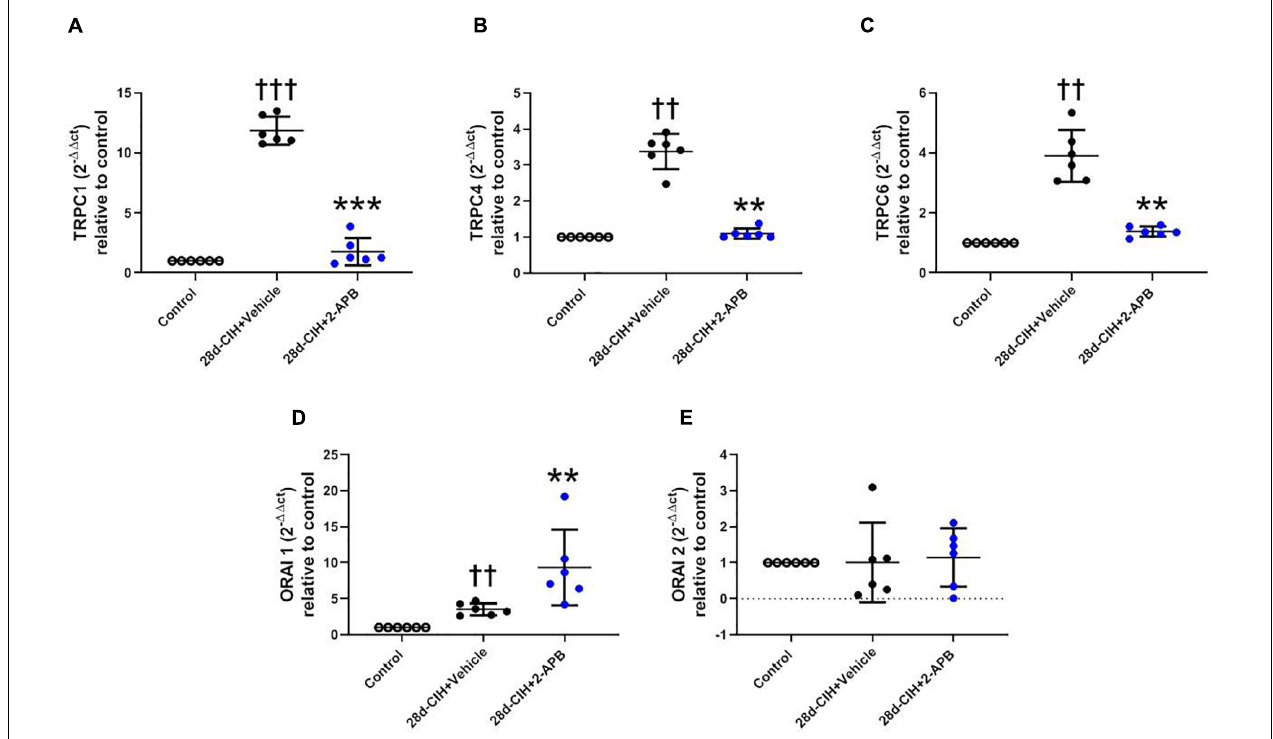
FIGURE 5 | Effect of 2-APB on the relative gene expression of STOC following chronic intermittent hypoxia. (A) relative lung gene expression of TRPC1 (ANOVA, P = 0.0001). (B) TRPC4 (ANOVA, P = 0.0017). (C) TRPC6 (ANOVA, P = 0.0003). (D) ORAI1 (ANOVA, P = 0.0005), and (E) ORAI2 (ANOVA, P = 0.9612) in control (empty circles, n = 6), Vehicle + 28d-CIH (black circles, n = 6), and 2-APB + 28d-CIH rats (blue circles, n = 6). Values expressed as 2 − (cid:49)(cid:49) CT related to the control. Mean ± SD. †† P < 0.01 vs. all groups, ††† P < 0.001 vs. all groups ** P < 0.01 vs. Vehicle + 28d-CIH, *** P < 0.001 vs. Vehicle + 28d-CIH, One way ANOVA-followed by Newman Keuls